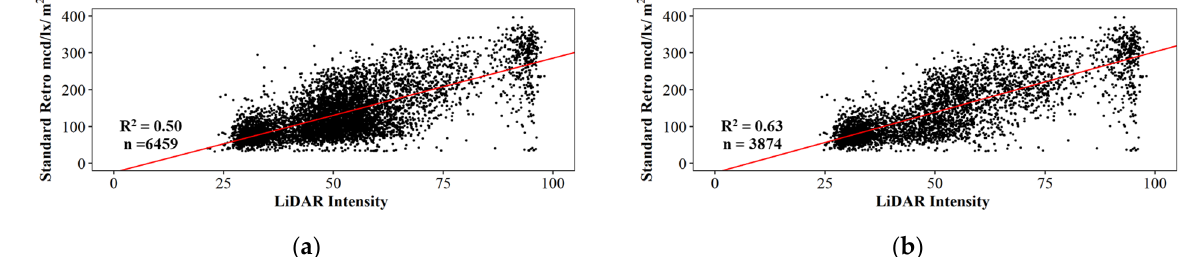
Figure 9. Center skip line linear correlation of LiDAR intensity and standard retroreflectivity: ( a ) US-52 and US-41 combined linear correlation of LiDAR intensity and standard retroreflectivity and ( b ) US-41 linear correlation of LiDAR intensity and standard retroreflectivity.